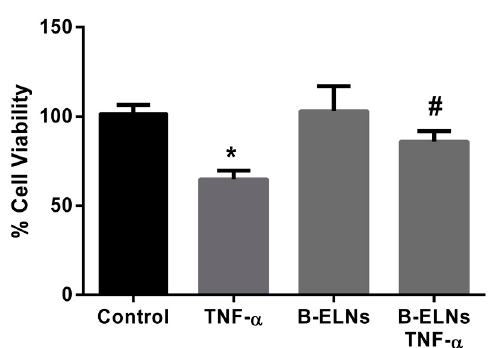
Figure 4. Viability of EA.hy926 cells (sulforhodamine B assay) after pretreatment with B-ELNs (20 μ g/mL) for 3 h, and then exposed for 2 h to tumor necrosis factor- α (TNF- α ) (20 ng/mL). Cell treated with the same volume of vehicle (PBS) were used as control. Data represent the percentages of viable cells compared to control and are expressed as mean ± SD of three separate experiments. * p < 0.05 vs control; # p < 0.05 vs cell exposed to TNF- α 20 ng/mL.